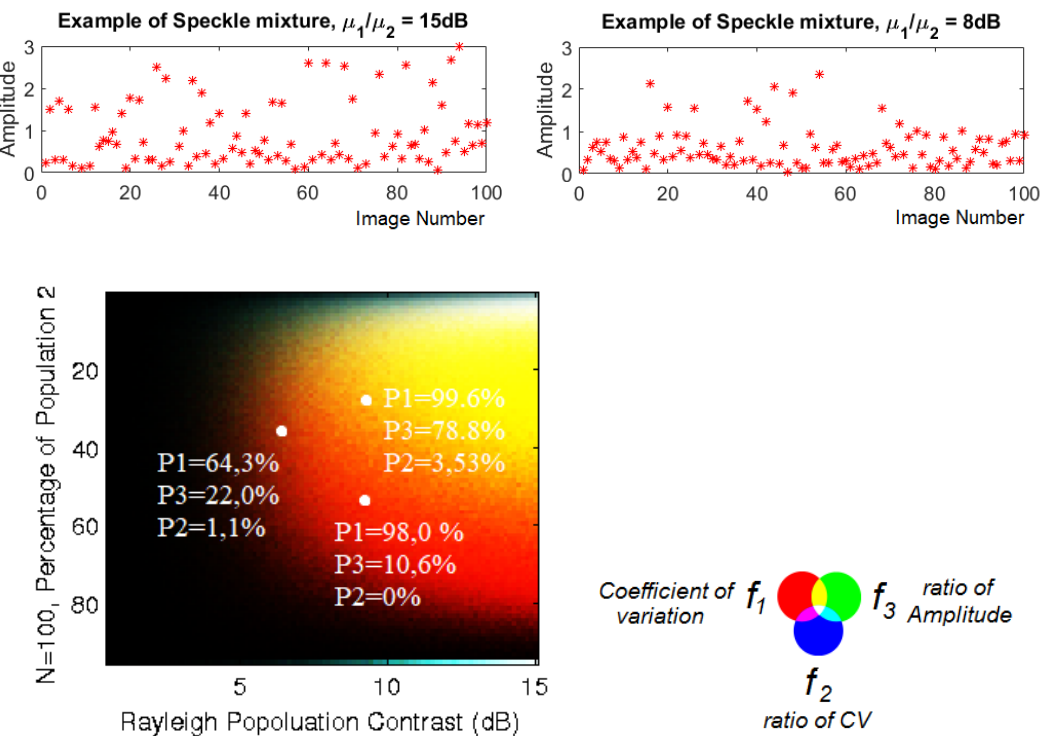
Figure 4. Top:examples of simulated profiles with mixture of two Rayleigh distributions, for two contrast ratios. Bottom: probability of detection of f 1 , f 2 , f 3 , for mixture of two Rayleigh speckle, for False Alarm 0.1%, for varying percentage of duration ratios and varying